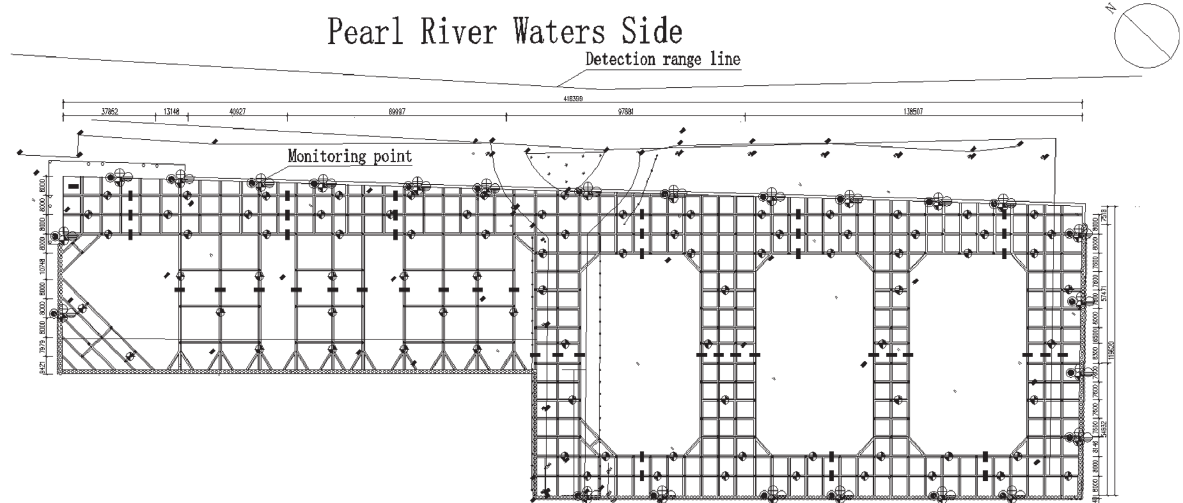
Figure 28: Plane layout of the foundation pit monitoring.